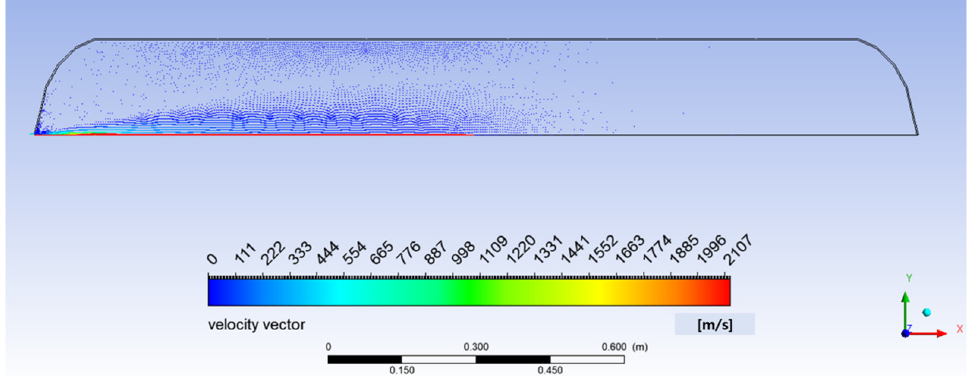
Figure 3. Representative velocity vector (hydrogen filling at 50 s under 5 MPa and 243 K).